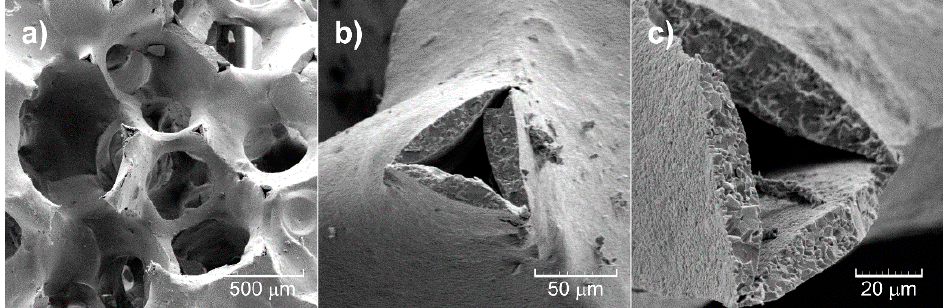
Figure 4. SEM images of the 30 ppi Al 2 O 3 foam substrate: ( a ) network, ( b ) bridges, ( c ) inner porosity visible on micrographs at high magnification.